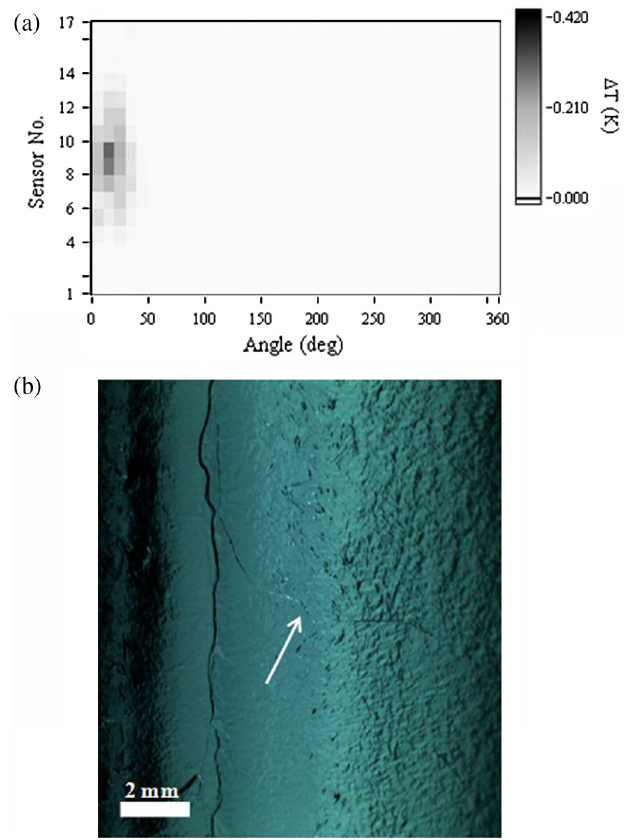
FIG. 8. ‘‘Unfolded’’ temperature map showing the temperature increase, (cid:2) T , above the He bath at 2.0 K during quench at 91 mT after heat treatment at 1400 (cid:1) C (a) and image of the inner cavity surface at the quench location showing the presence of a grain boundary (b).